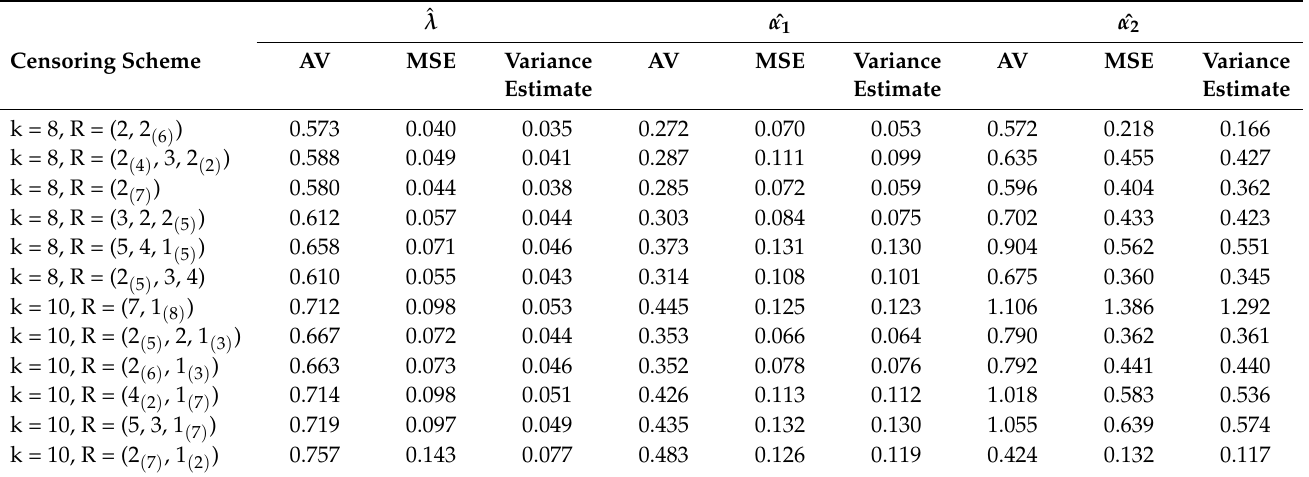
Table 1. MSEs and AVs of the MLEs of the model parameters with λ = 0.5, α 1 = 0.4, α 2 = 0.8 based on different